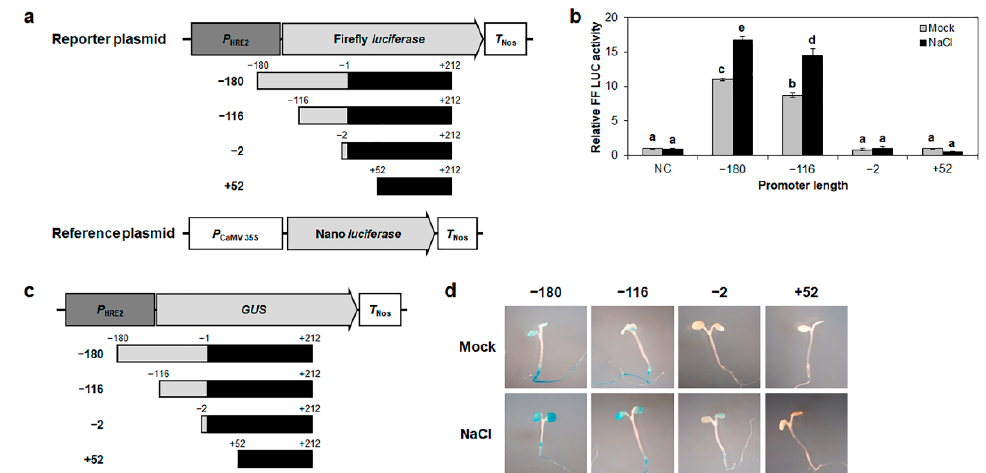
Figure 3. HRE2 promoter deletion analysis under salt stress condition. ( a ) Schematic maps of reporter and reference plasmids for HRE2 promoter deletion series analysis. ( b ) Relative firefly luciferase activity in Arabidopsis protoplasts. Transformation efficiency was normalized using Nano luciferase activity. Normalized firefly luciferase activity of negative control in mock was set as 1. Empty reporter plasmid was used for negative control. Data are shown as means ± S.D. ( n = 3). Different letters display significant differences ( p < 0.05). ( c ) A schematic map of vector for HRE2 promoter deletion series analysis. ( d ) Histochemical GUS assay of Arabidopsis T 2 transgenic plants carrying the deletion series of HRE2 promoter at 7 DAG under SD conditions. GUS activity was observed in at least 15 transgenic plants for each construct; representative staining results are shown here. In ( b , d ), mock indicates normal condition.